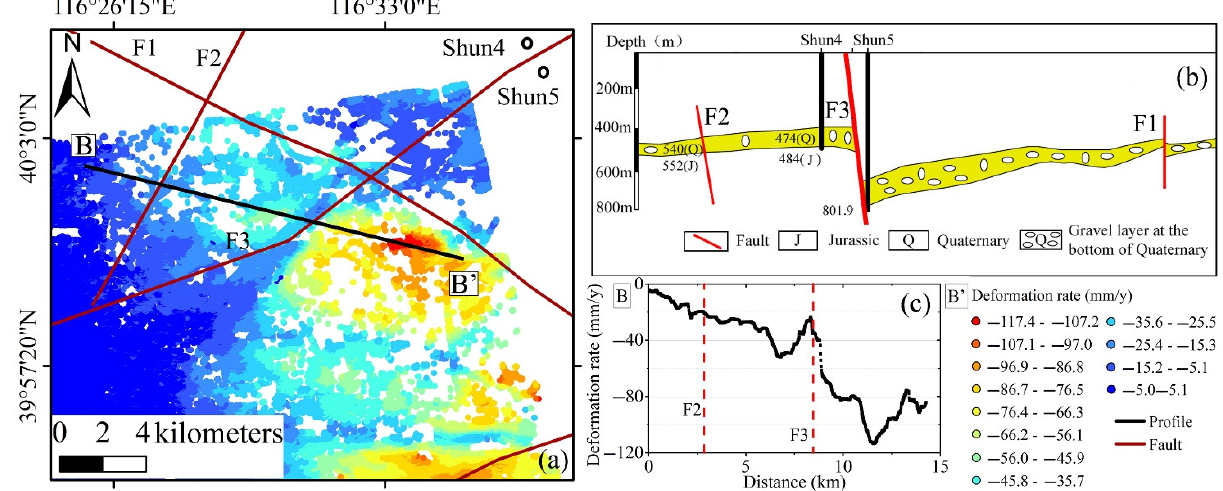
Figure 14. ( a ) Distribution of land subsidence in active fault areas. ( b ) Profile of the Shunyi fault. (derived from [57]). ( c ) Profiles of deformation rates on both sides of the faults (B-B’).